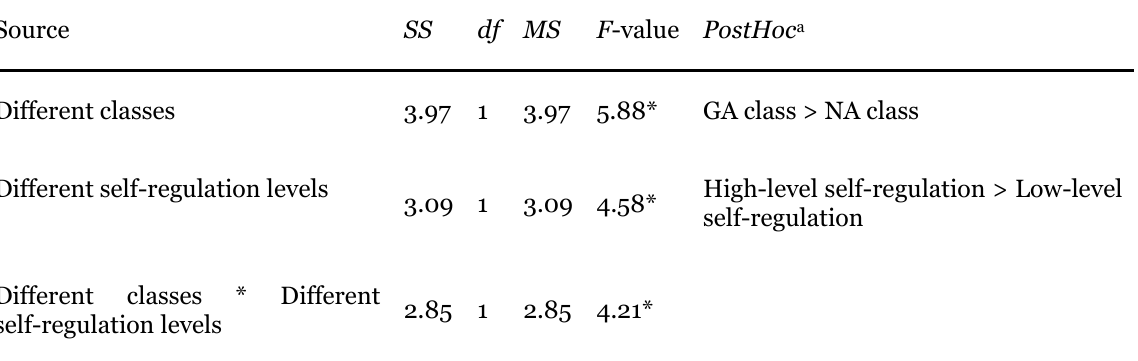
Two-Way ANOVA of Requesting Rate (n=99)